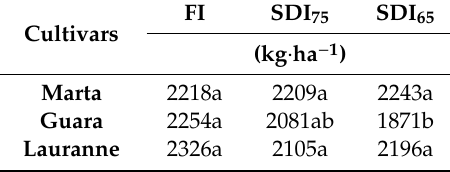
Table 2. Kernel yield for di ff erent cultivars and irrigation